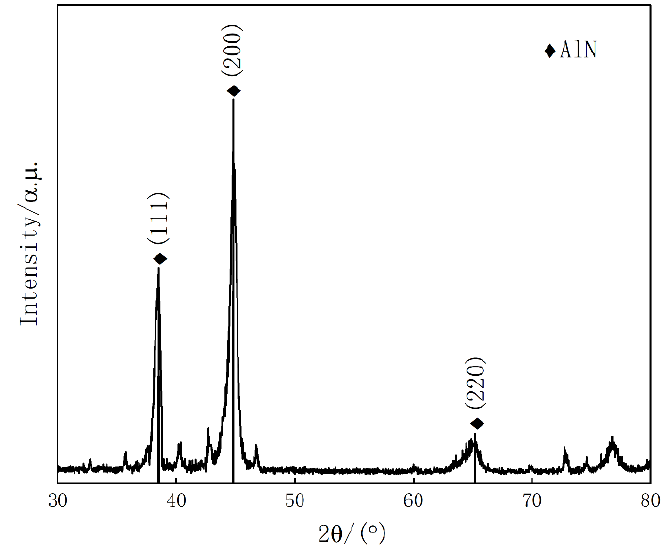
Figure 7. XRD pattern of the coating.